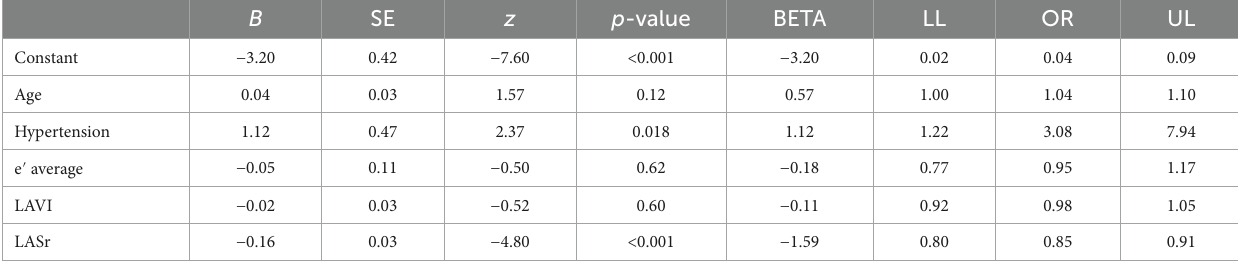
TABLE 3 Predictors of diastolic function worsening over time; multivariate logistic regression analysis.